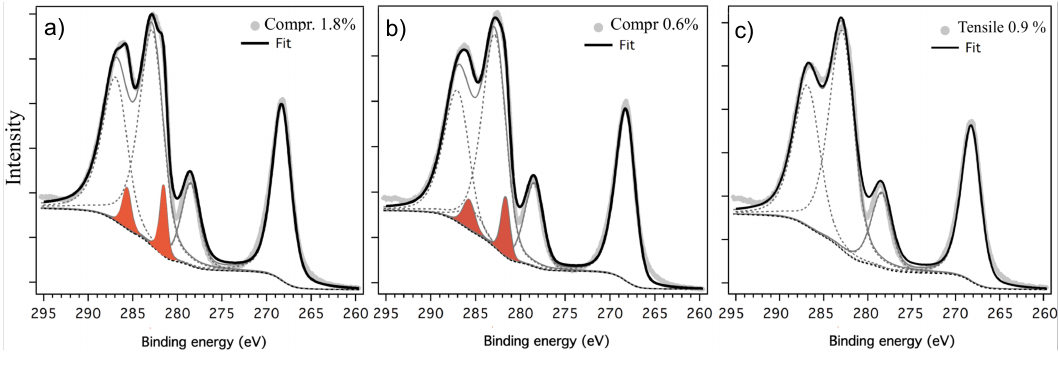
Figure 7. High-resolution XPS scans of Ru-3d/Sr-3p peaks for SRO films grown on NGO ( a ), STO ( b ) and GSO ( c ); photon energy was h ν = 850 eV. Results of fitting procedures are also reported (area of well-screened peak in enlighten by red filling